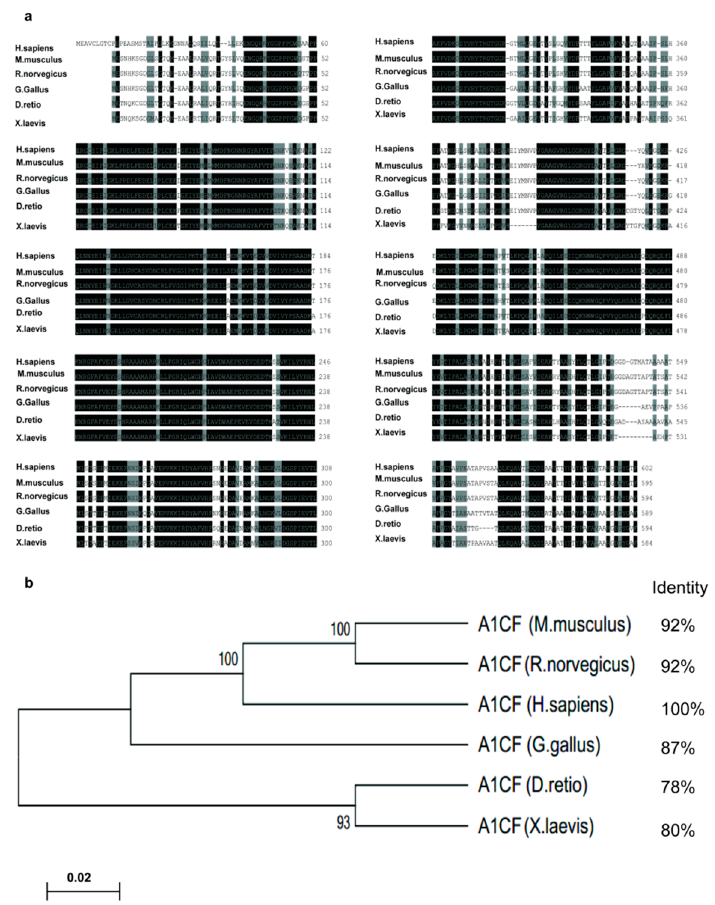
Figure 1. Apobec-1 complementation factor (A1CF) is highly conserved among species. ( a ) A1CF amino acid sequences of human , mouse , rat , chicken , zebrafish , xenopus laevis were selected to analysis. The identical amino acids were shaded in black and the similar amino acids in grey; ( b ) Phylogenetic tree of A1CF amino acids is constructed using MEGA6 software, bootstrap percentages based on 1000 replicates, are shown on each branch. Identity values are listed on the right ranging from 78% to 92%, revealing that A1CF is highly conserved among species.